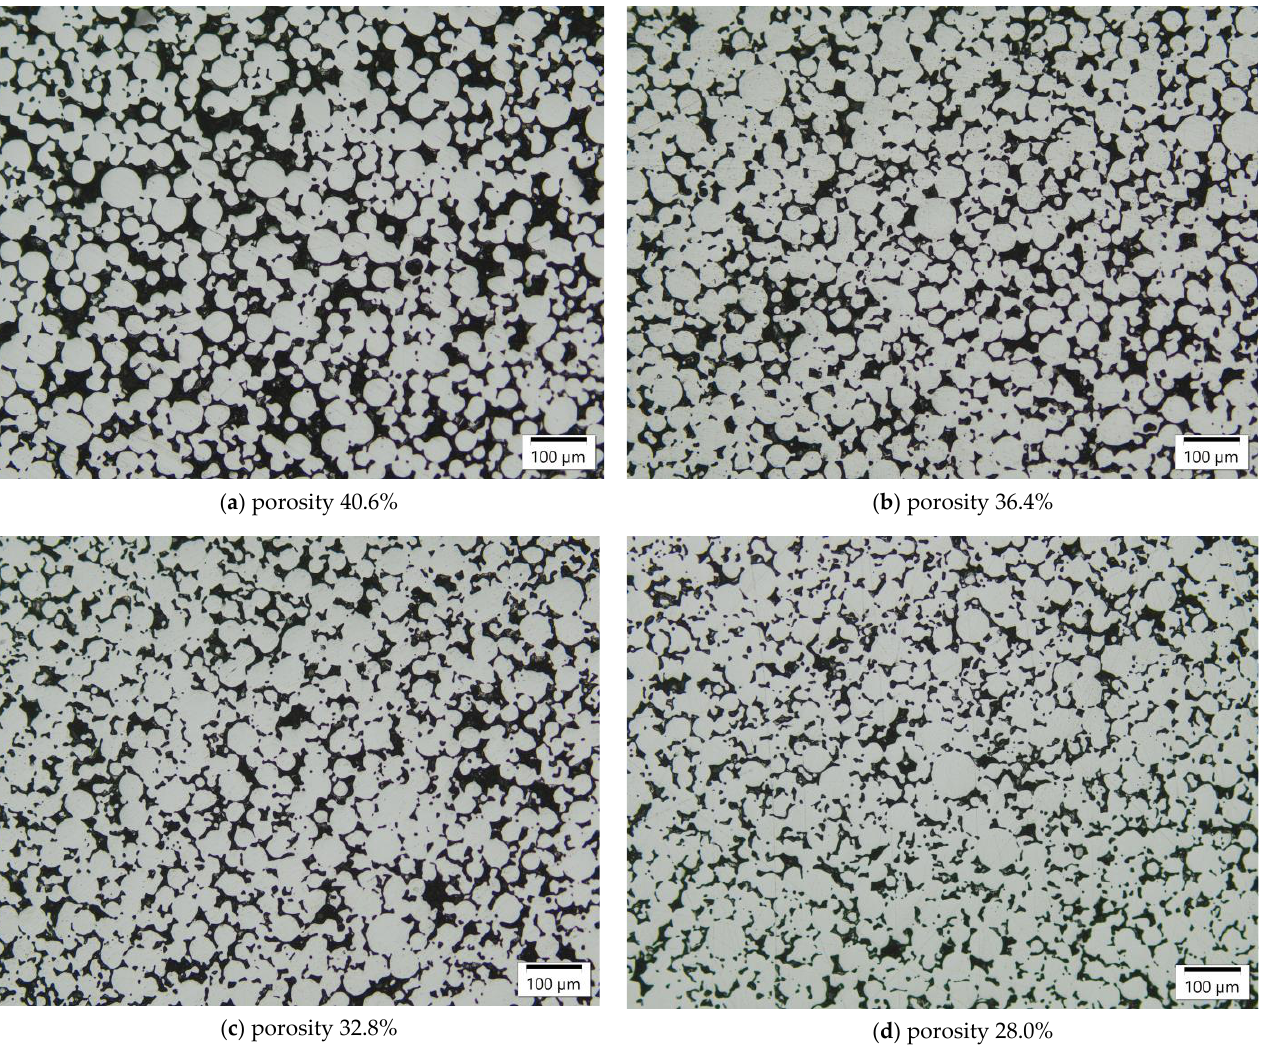
Figure 4. Pore structure for H11 tool steel preforms sintered for 3 h at 1200 ◦ C with ( a ) 0 wt.%, Figure 4 . Pore structure for H11 tool steel preforms sintered for 3 h at 1200 °C with ( a ) 0 wt.%, ( b ) 5 ( b ) 5 wt.%, ( c ) 10 wt.% and ( d ) 15 wt.% fine powder addition, imaged by optical wt.%, ( c ) 10 wt.% and ( d ) 15 wt.% fine powder addition, imaged by optical microscopy.